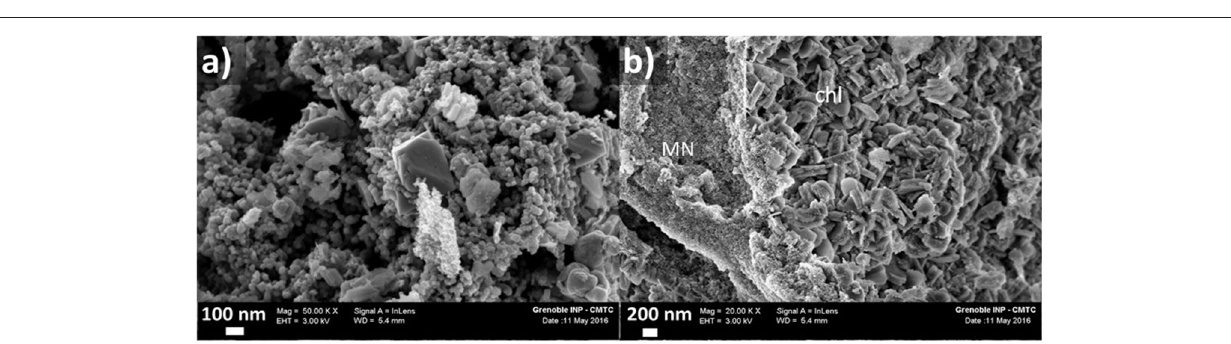
FIGURE 9 | FE-SEM imaging of solid samples recovered after hydrothermal oxidation at 250 ◦ C in 1M acetic acid solution; (a) magnetite nanoparticle clusters; (b) magnetite nanoparticles (MN) and lamellar nanoparticles interpreted as chlorite